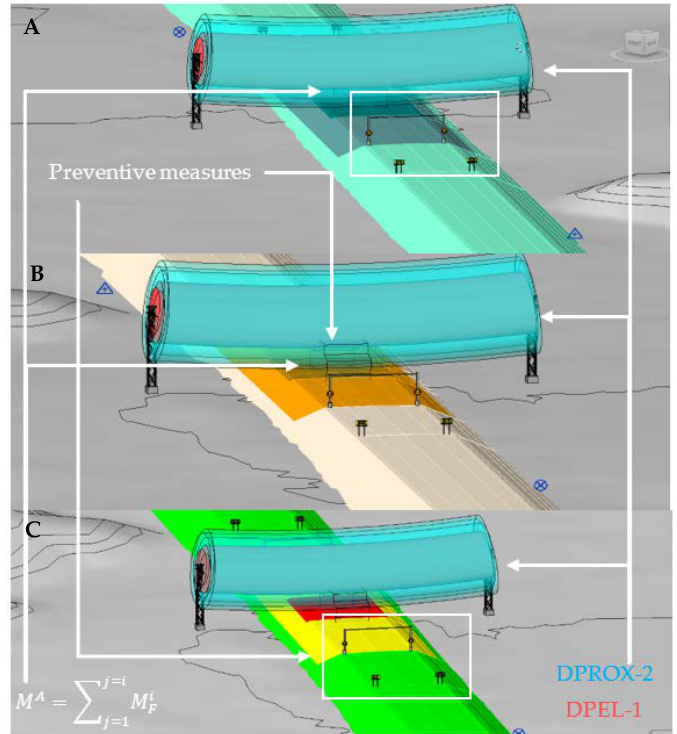
Figure 9. Risk reassessment of the study area (color coded according to Table 1). ( A ) Risk probability (1 = light blue, 2 = medium blue, 3 = dark). ( B ) Risk severity (1 = light orange, 2 = medium orange, 3 = dark orange). ( C ) Risk assessment (1 = light green, 2 = dark green, 4 = yellow, 6 = orange, 9 = red). Note: Delimitation of the zones according to the diagram in Figures 2 and 3.